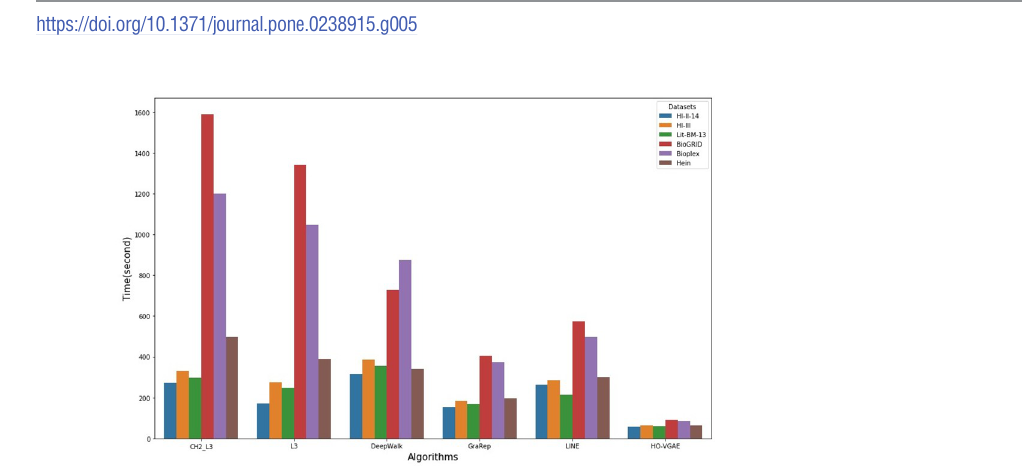
Fig 6. Running times on six datasets for different link prediction